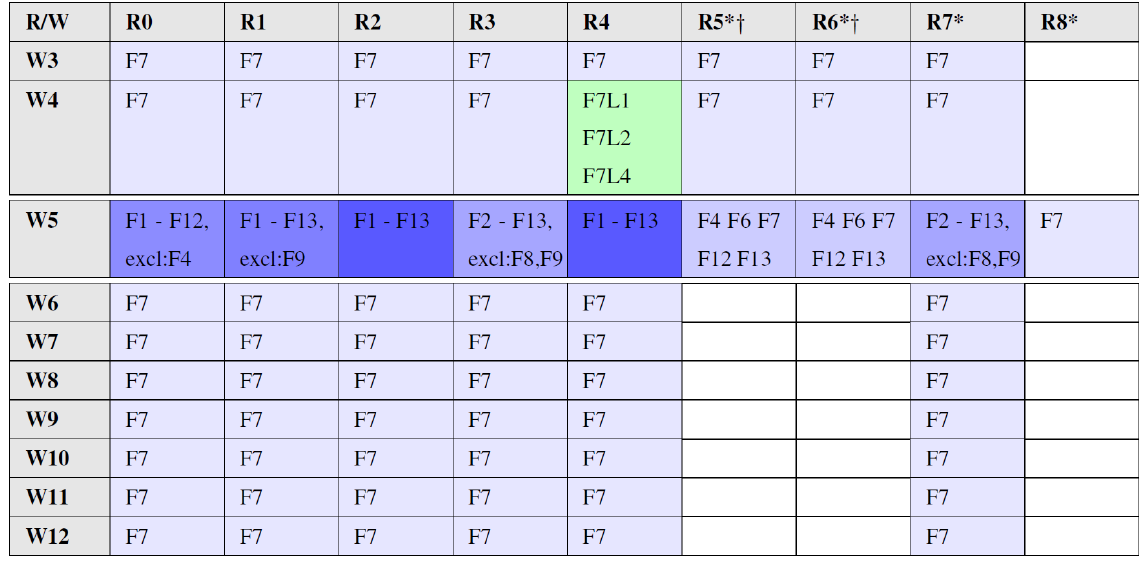
Table B1. Combinations of test conditions resulting in penetrative plumes, as captured by the LES datasets. Green cells highlight fireline length condition ( L ) runs. The intensity of the blue color corresponds to the number of runs for fuel condition ( F ) represented by the cell. Row W5 is expanded in Table B2 below.